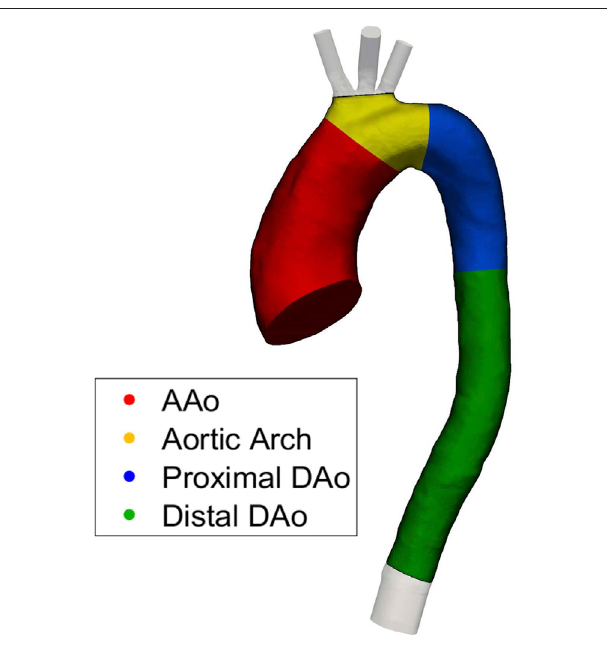
FIGURE 1 | Four regions of interest (ROIs) used for quantitative regional